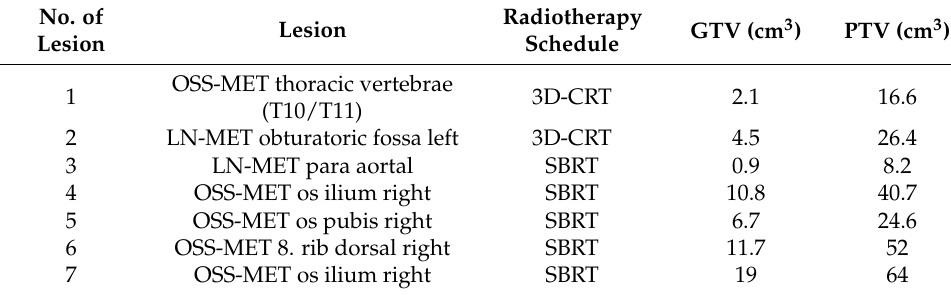
Table 3. Description of the seven local progressing lesions.